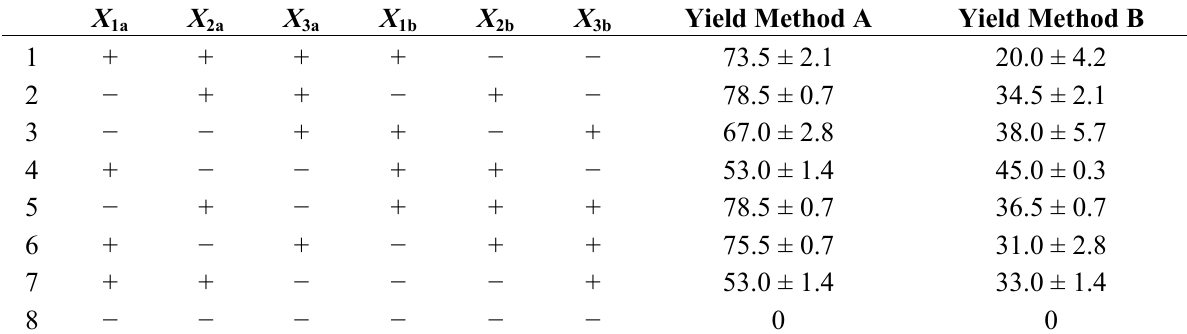
Table 2. Design matrix and response values in Plackett–Burman factorial design for MAOS AS101